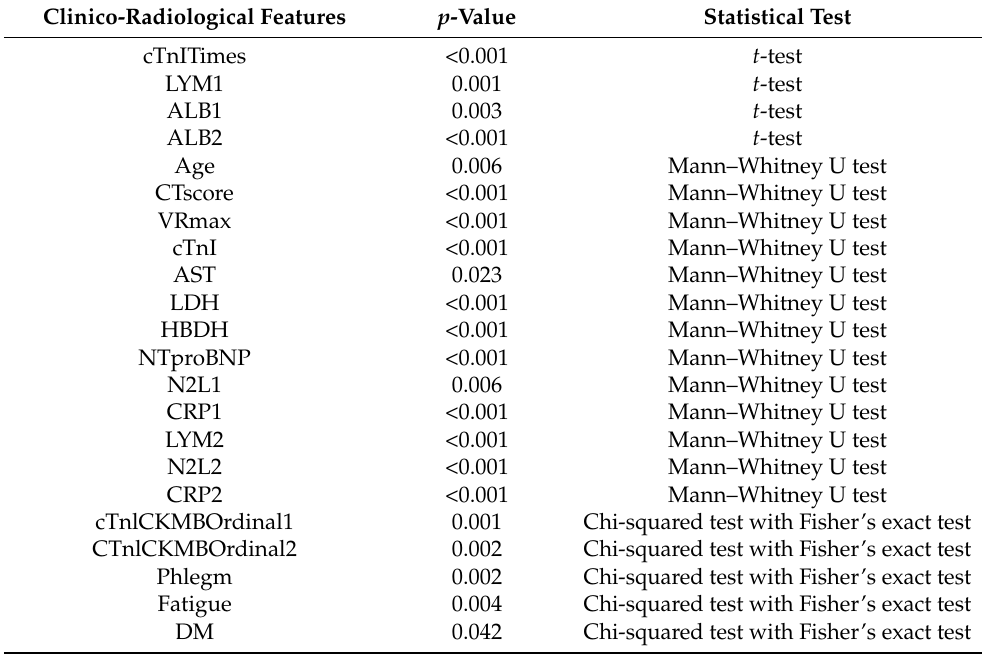
Table 1. Statistically significant ( p value < 0.05) clinico-radiological features of severity in two-type classification.